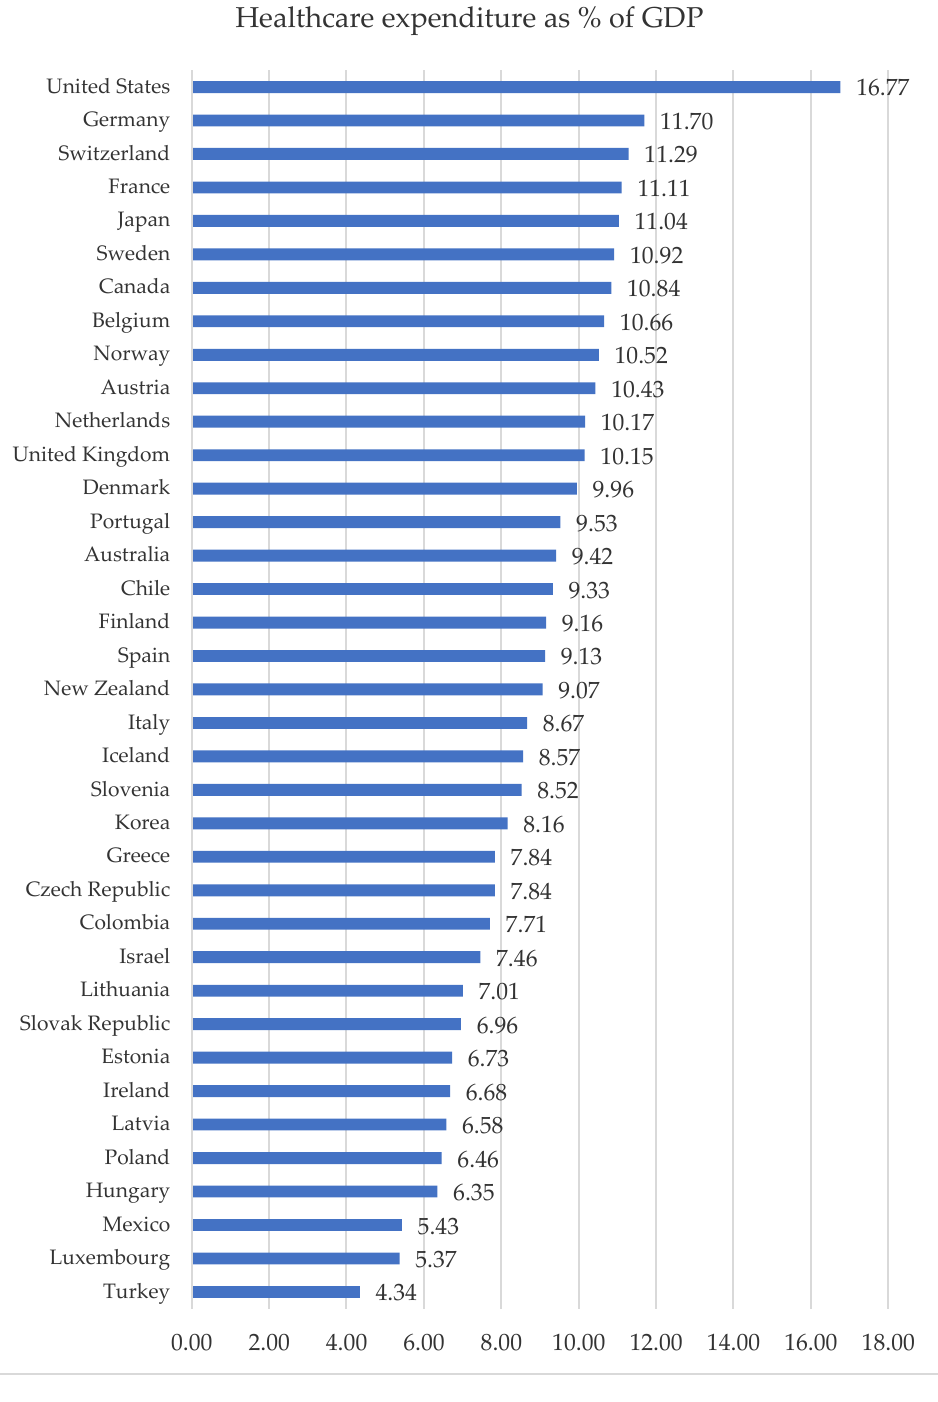
Figure 1. Healthcare expenditure as % of GDP in 2019 [23].